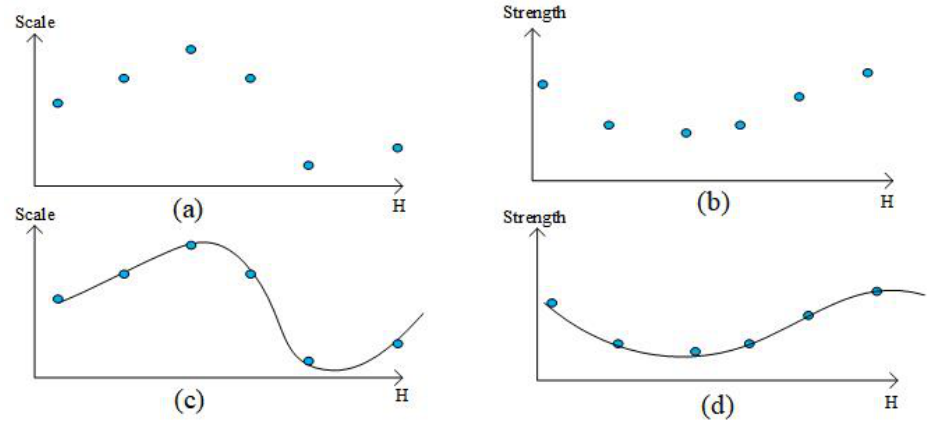
Figure 5. The curve fitting technique. The strength and scale features extracted from each frame are represented by a point in ( a , b ). Therefore, the number of the points is equal to the frame number. Then, using the cubic polynomial interpolation method to fit the curves, we get feature curve ( c , d ). Given matrices B 1 and B 2 ∈ R ( H − 1 ) × W , we vectorize the matrices B 1 and B 2 to